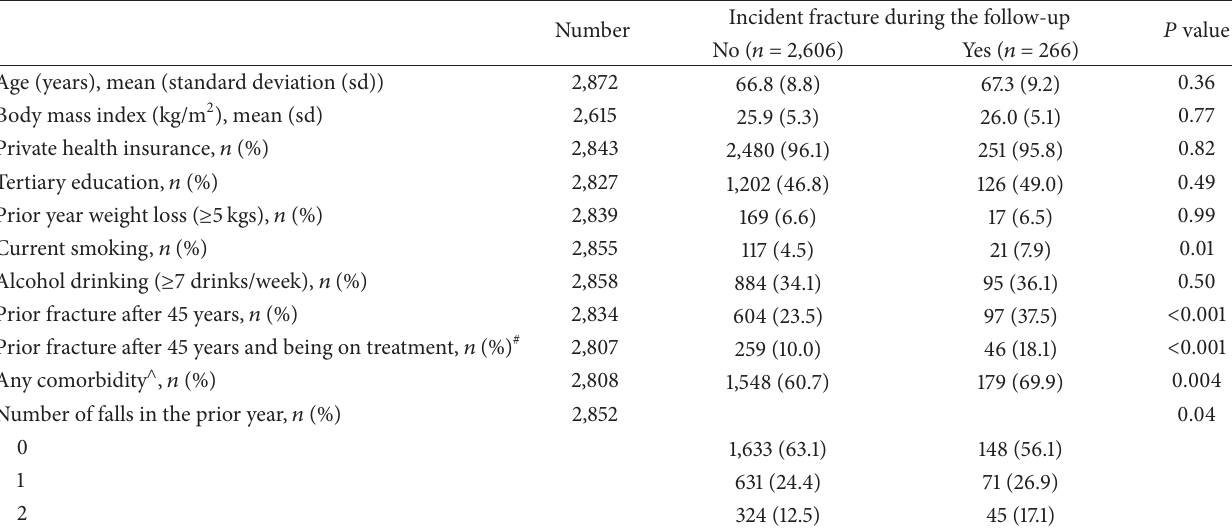
Table 1: Baseline (first assessment) characteristics of the study